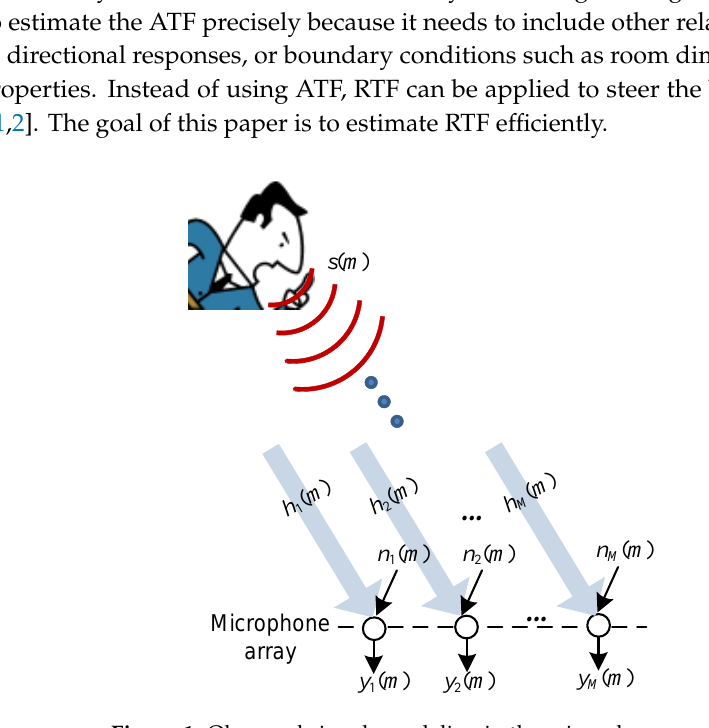
Figure 1. Observed signals modeling in the microphone array.